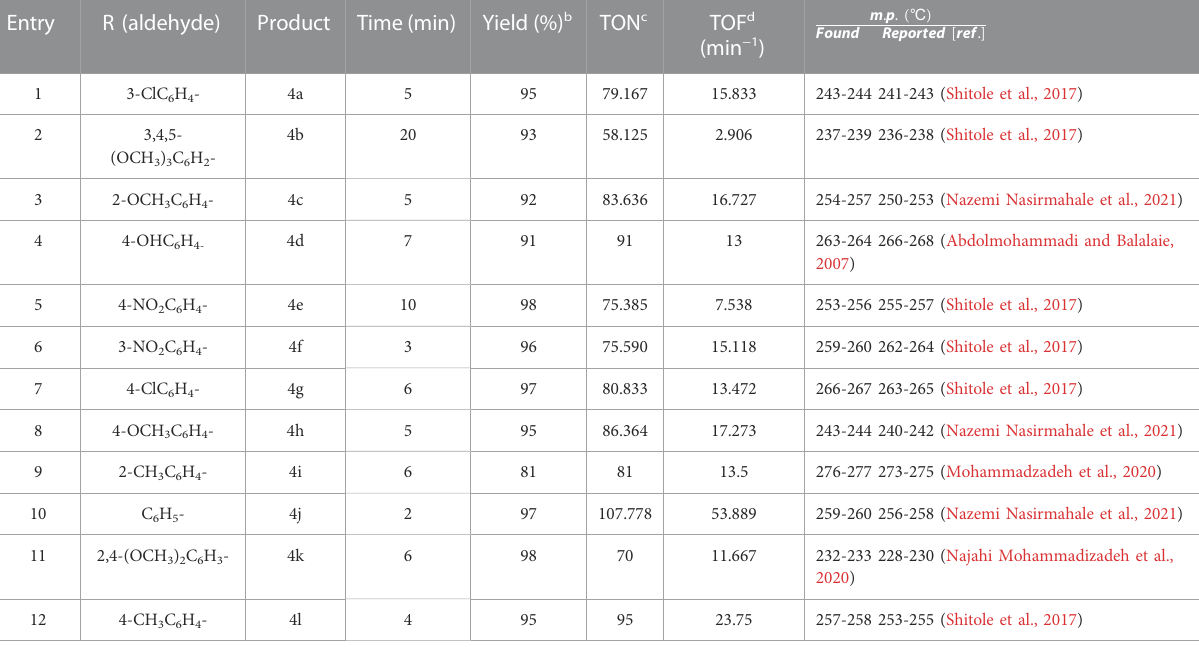
TABLE 2 Preparation of 3,4-dihydropyrano [c]chromenes using CB Fe-MOF@Fe 3 O 4 NFC as organic nanocatalyst.